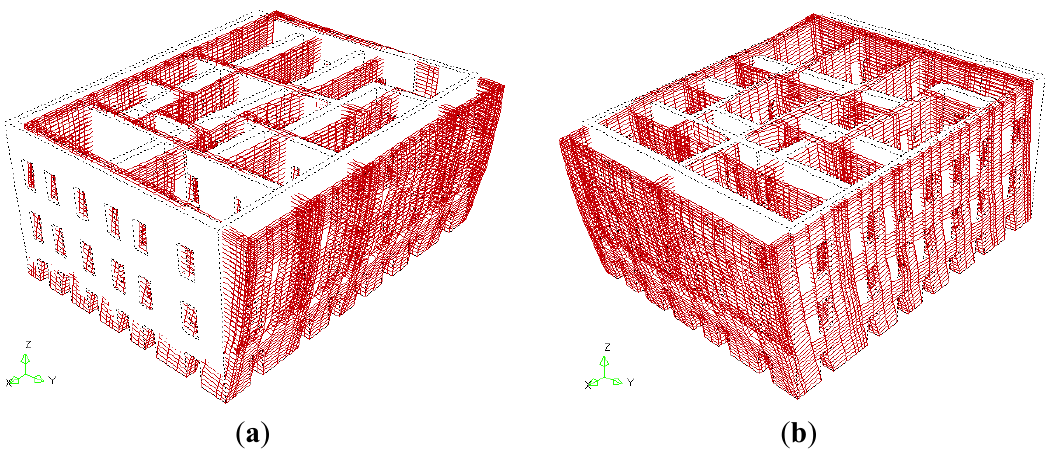
Figure 7. Modal shapes given by the 3D model for the building without the underground